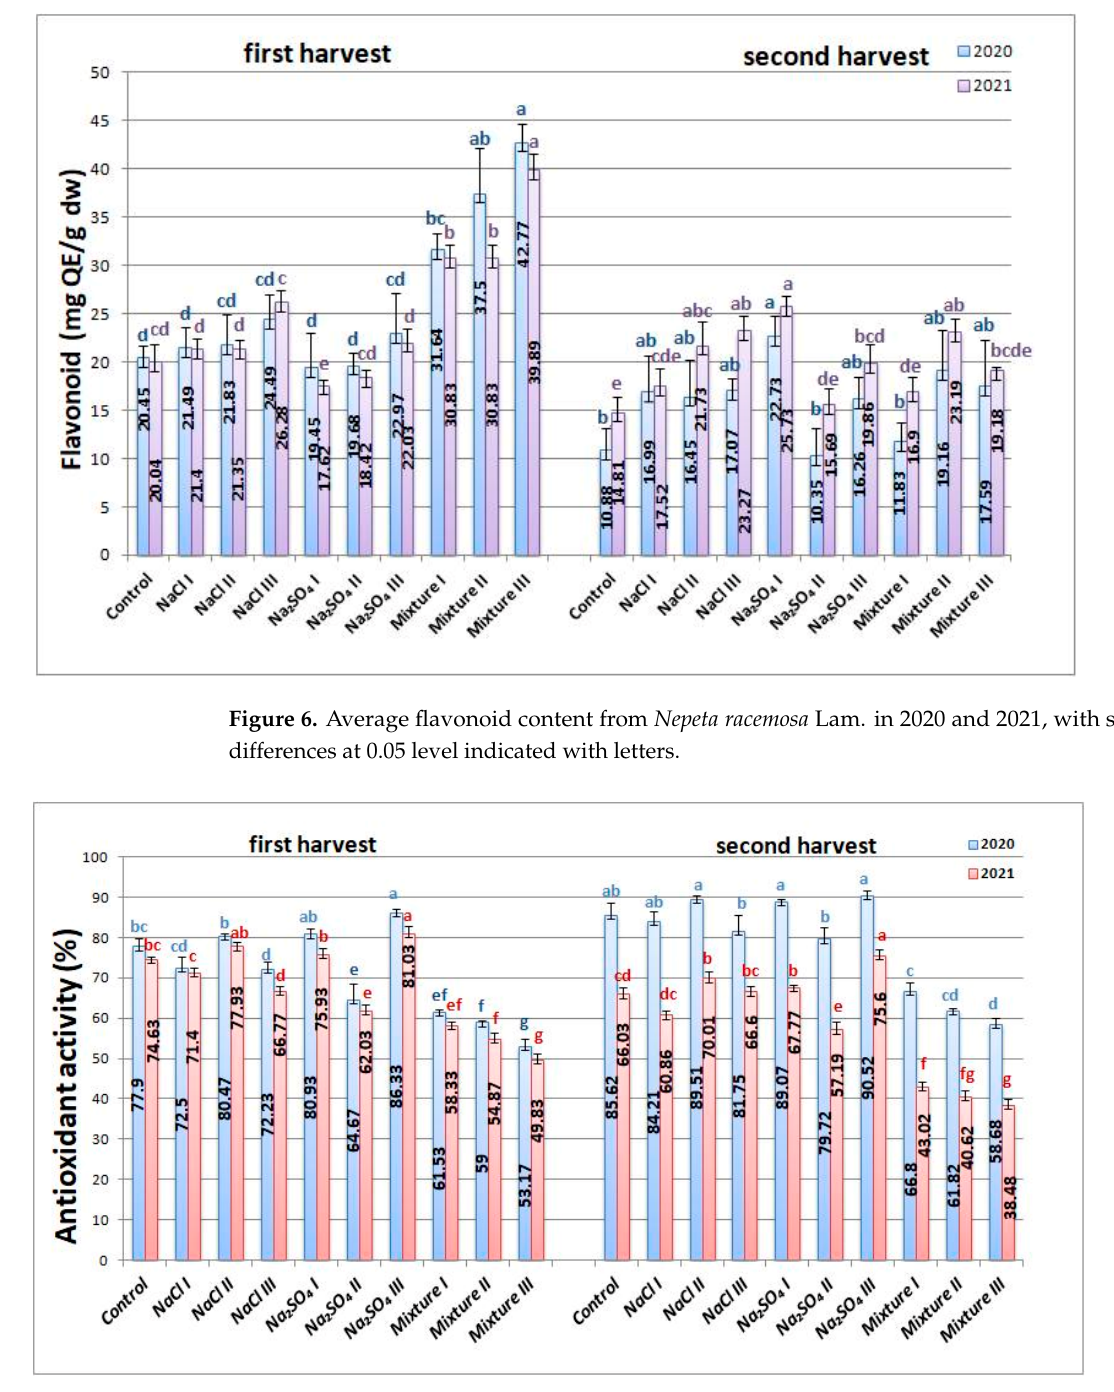
Figure 7. Antioxidant activity of Nepeta racemosa Lam. variants in 2020 and 2021, with significant differences at 0.05 level indicated with letters.